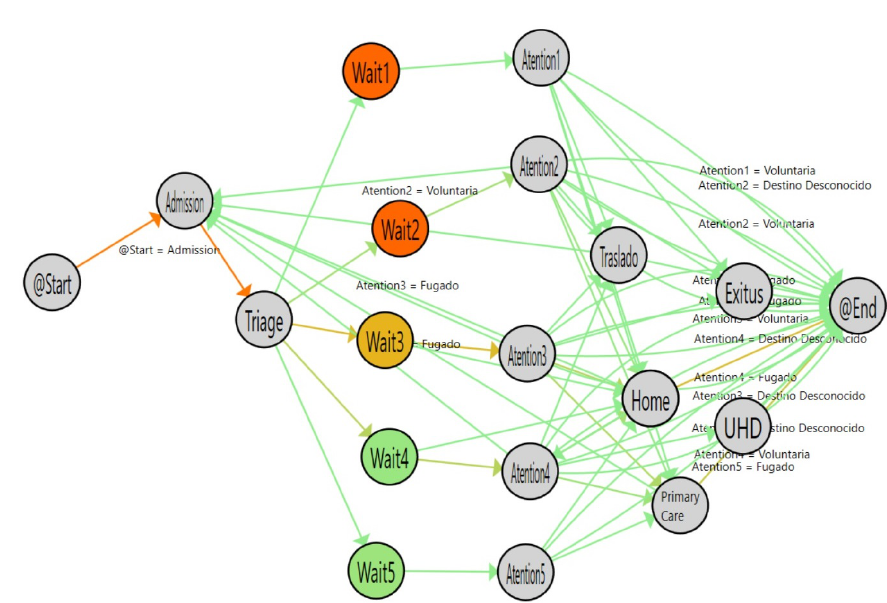
Figure 15. Adequacy of treating Ordinary patients according to the Manchester Standard.